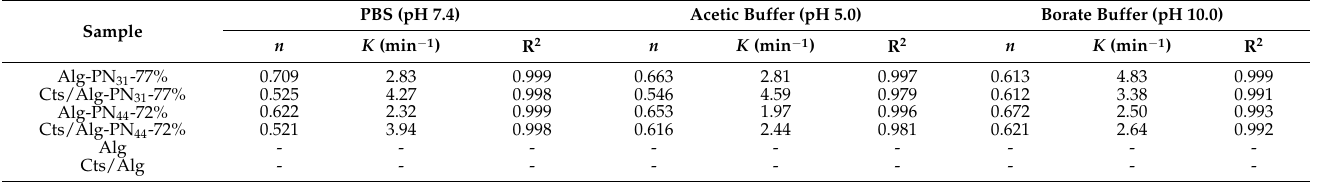
Table 4. Release kinetic characteristics of deferent hydrogel samples in PBS buffer (pH 7.4), acetic buffer (pH 5.0), and borate buffer (pH 10.0) a